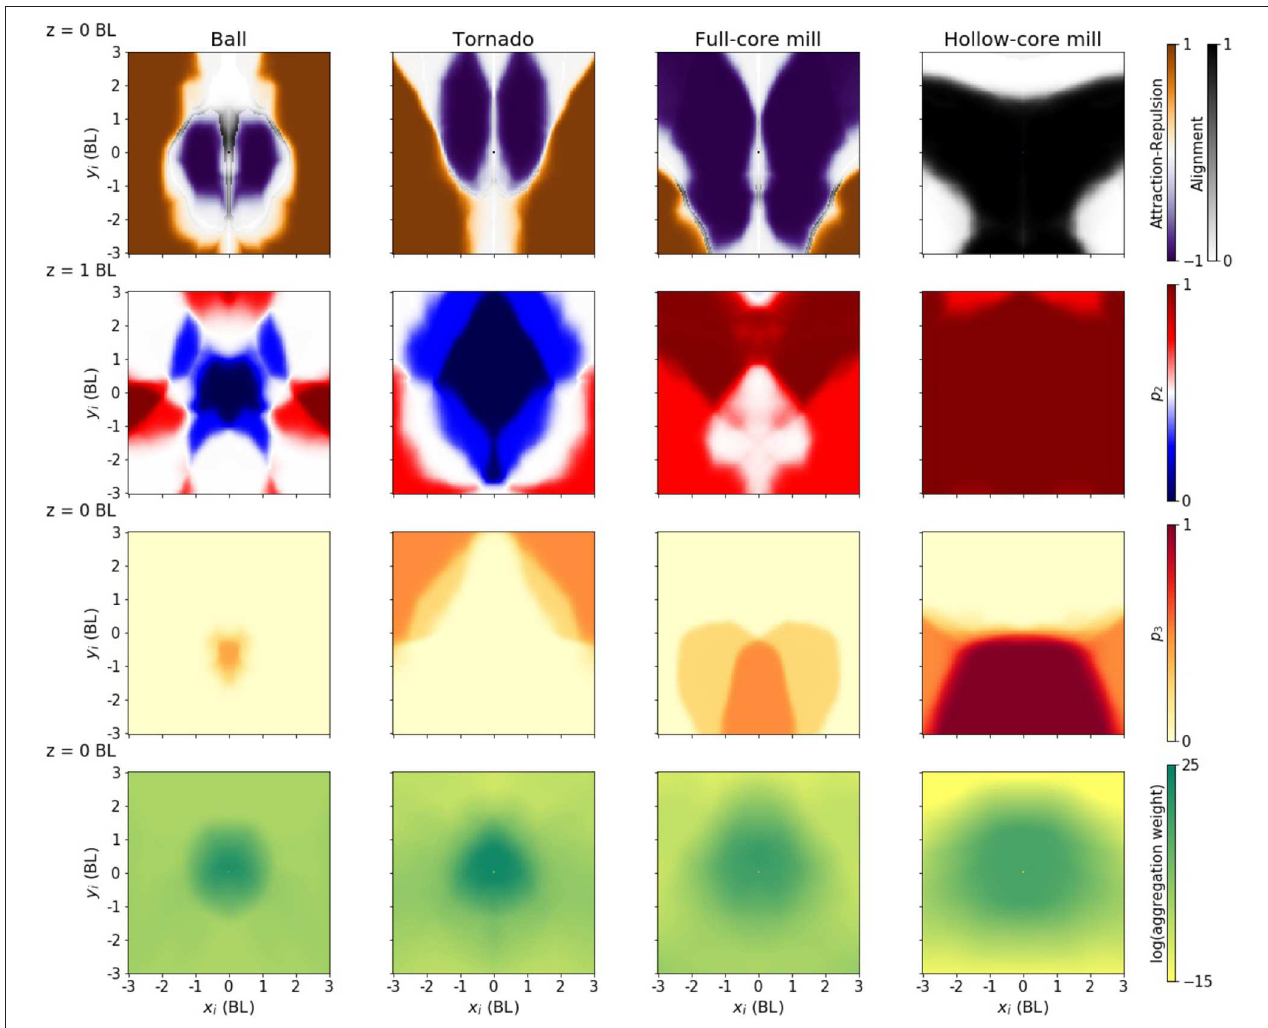
FIGURE 6 | Policies producing different configurations. Each column corresponds to one of the four desired configurations. Each panel is the equivalent of the middle row in Figure 5 , except in the case of the elevation (second column), that is equivalent to the panel in the top row. For each configuration, the speed of the focal and neighbor has been fixed to the configuration median: 0.42, 0.32, 0.75, and 1.54 BL/s,